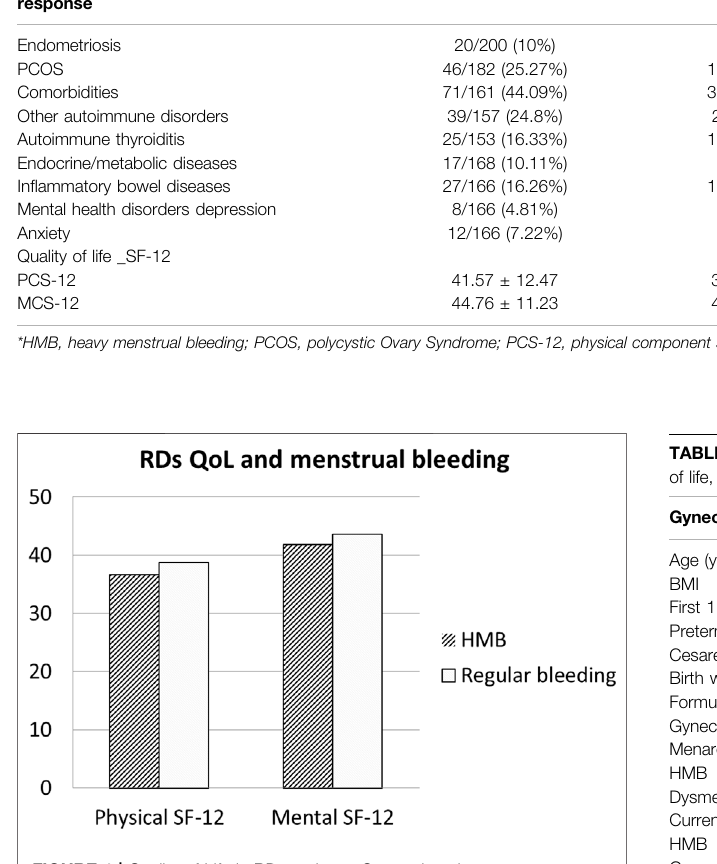
FIGURE 1 | Quality of Life in RDs patients: Comparison between patients with regular bleeding and HMB. Legend: RDs: Rheumatic diseses.